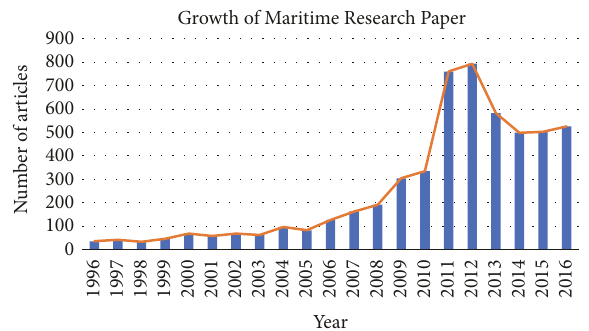
Figure 1: Growth of maritime research